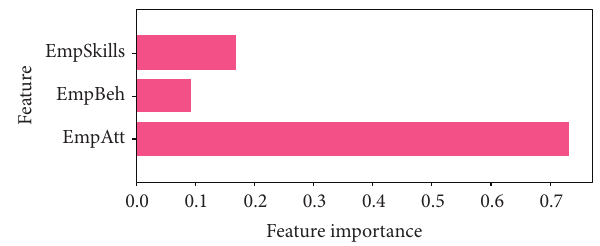
Figure 21: Feature importance. Table 5: Training and test datasets